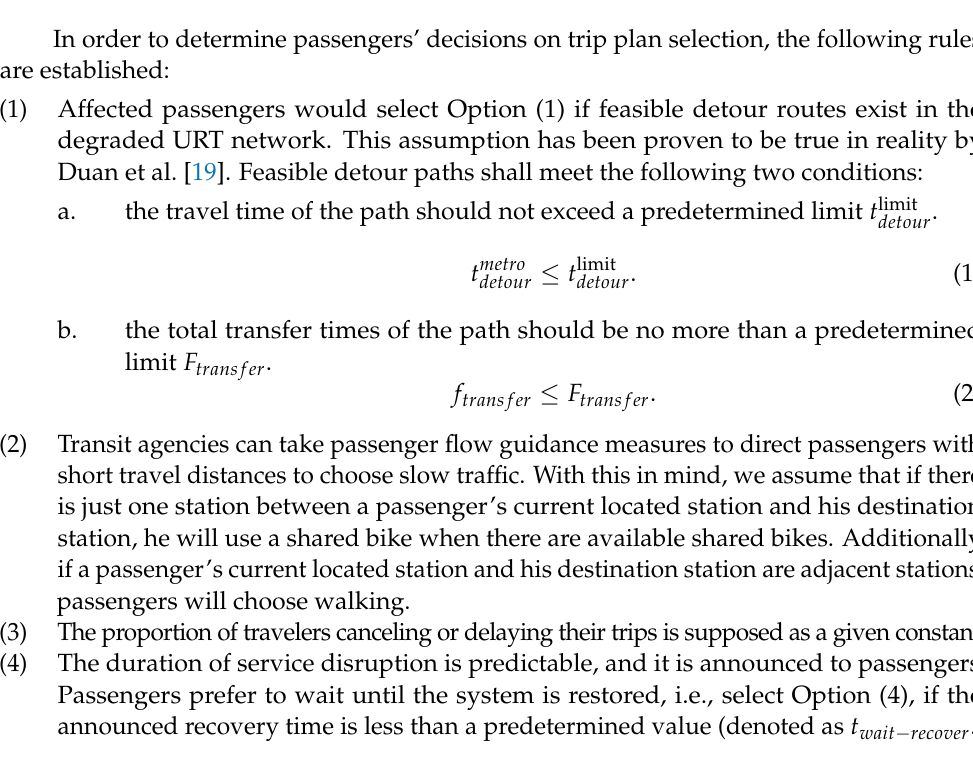
Table 4. The tap-in time domains in which Option (1) is available to passengers of the fourth category. Passengers of the Fourth Category The Tap-In Time Domain Non-transfer passengers T + t spread − t metro From Line 1 to Line Transfer passengers